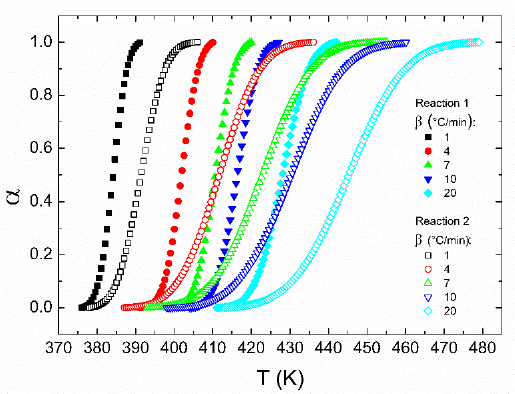
Figure 4. Non-isothermal degree of conversion as a function of both cure temperature and heating rate for the deconvoluted reactions. The relative weight of each reaction is not considered here.